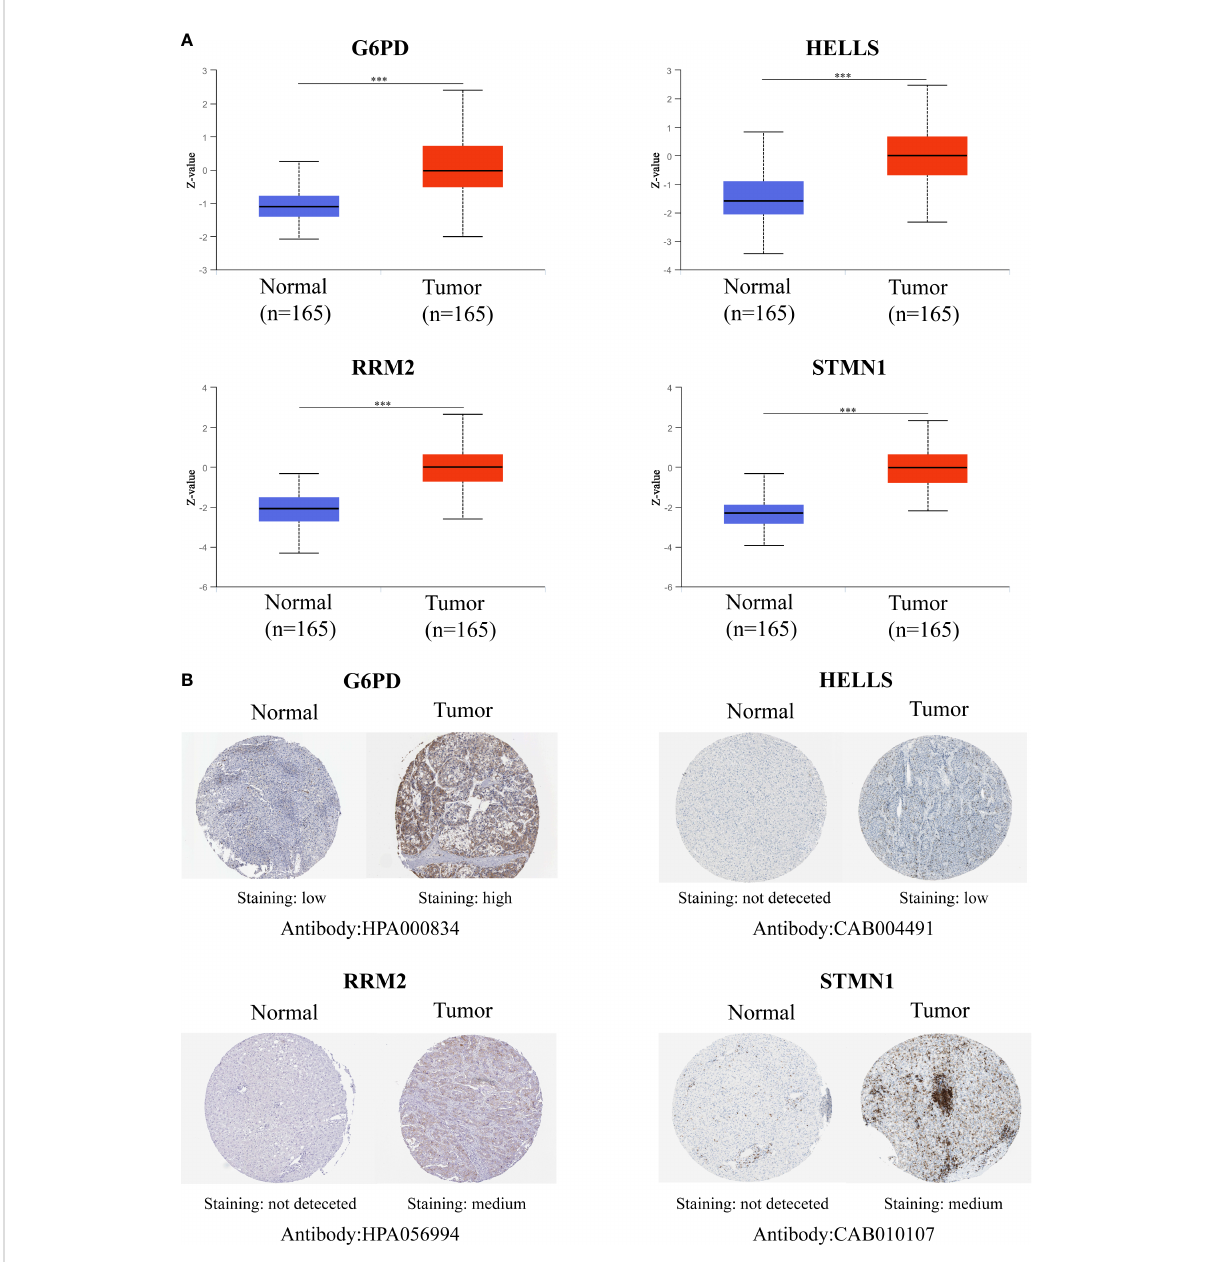
FIGURE 6 Validation of the Protein expression for four hub FRGs. (A) Protein expressions of four hub FRGs were signi fi cantly up-regulated in patients with HCC from the CPTAC database. (*P <0.05; **P <0.01; ***P <0.00001) (B) Representative immunohistochemistry staining of four hub FRGs. Protein expression levels of G6PD, HELLS, RRM2, and STMN1 in HCC tissue were obtained from the Human Protein